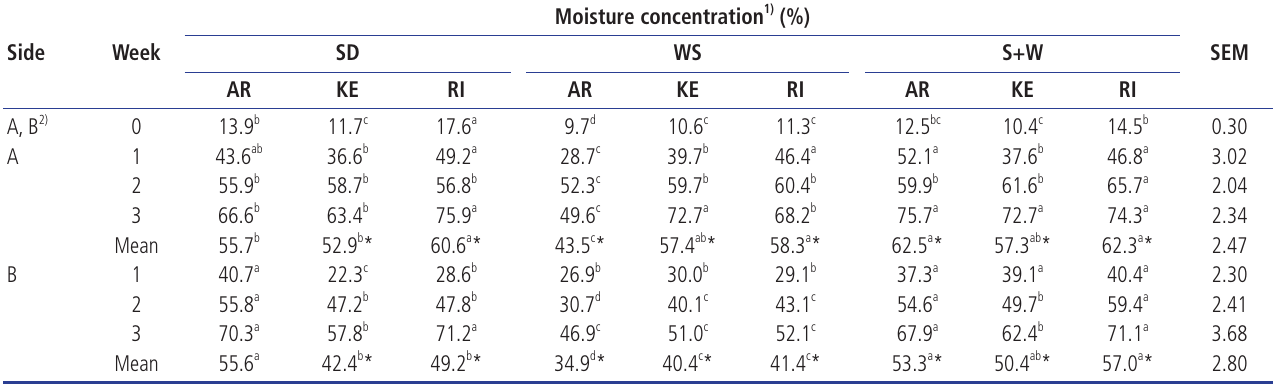
Table 7. Effects of bedding materials by the species of pine trees and pen location on moisture concentrations of beddings for rearing Hanwoo Side